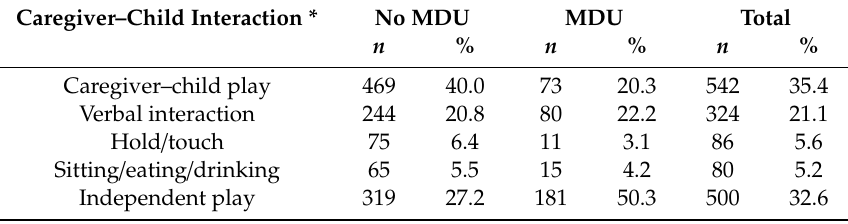
Table 2. Caregiver–child interaction by minutes of no mobile device use (No MDU) compared with minutes of mobile device use